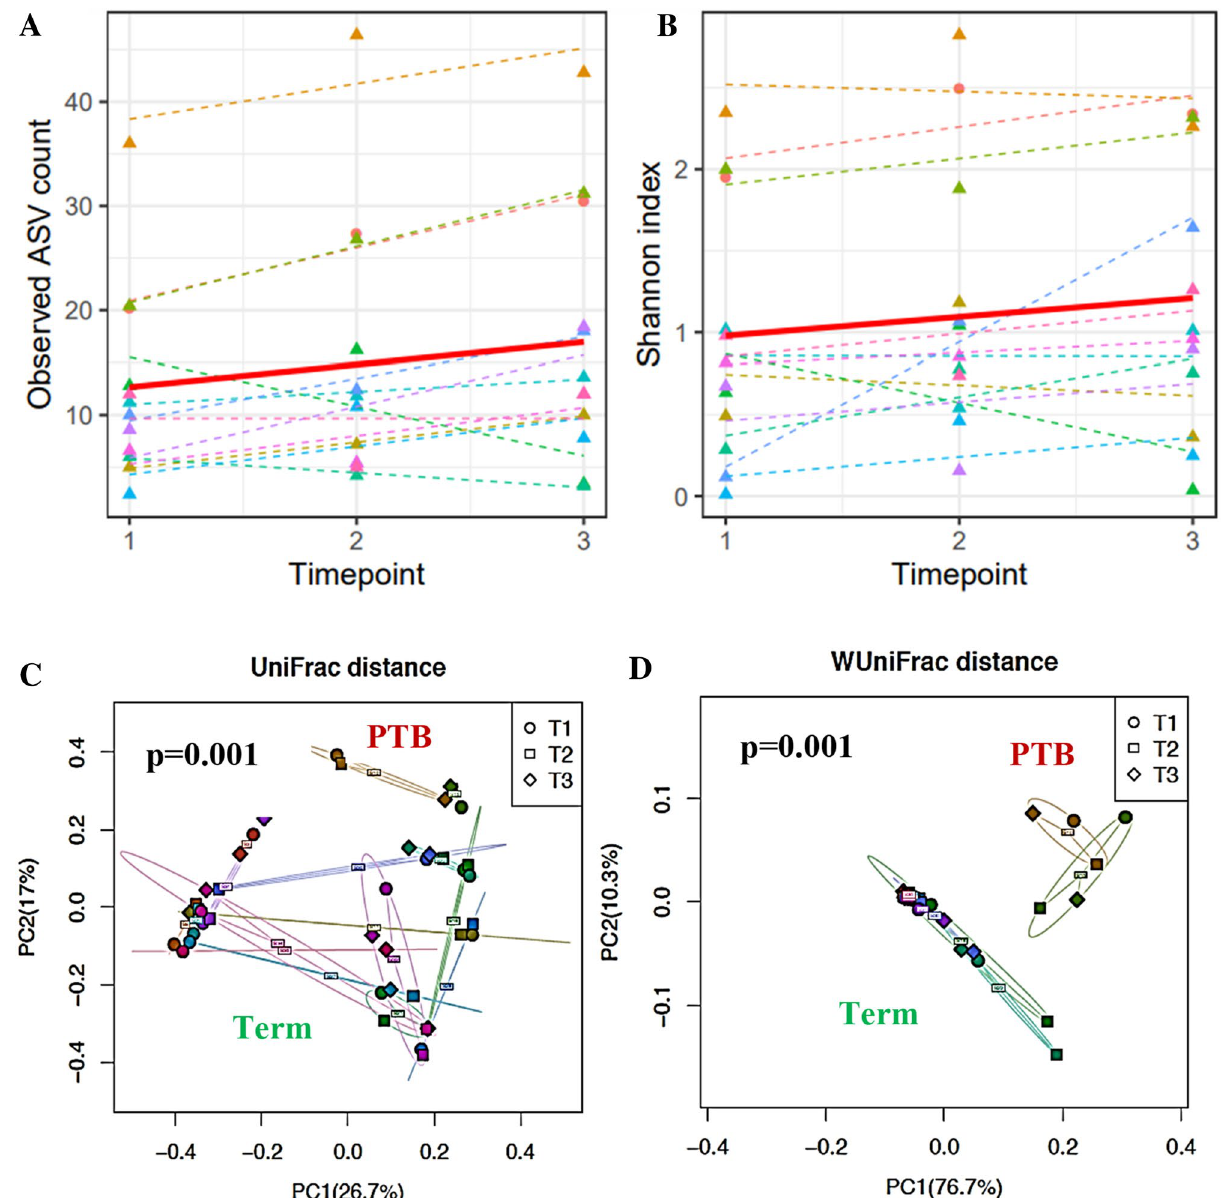
Figure 3. Longitudinal trends in diversity of the vaginal microbiome with increasing gestational age. Each timepoint represent gestational weeks of pregnancy; timepoints 1 (17–21 gestational weeks), timepoint 2 (27–31 gestational weeks) and Time point 3 (17–21 gestational weeks). (A,B) Alpha diversity increased with increasing gestational age (p = 0.006 and p = 0.07; LMM) for observed amplicon sequence variant (ASV) and Shannon diversity respectively. Each color represents a participant. Preterm birth (PTB participants are the top two participants depicted with light lemon and orange dash line. The dash line indicates the individual trend while the solid line indicates the overall trend (population-level trend). (C) Longitudinal beta diversity show separate community structure across term and preterm group ( unweighted UniFrac). (D) Longitudinal beta diversity show separate community structure across term and preterm group ( weighted UniFrac). Time points are identified with shapes (Circular, Timepoint 1; Square, Timepoint 2; Sphere, Timepoint